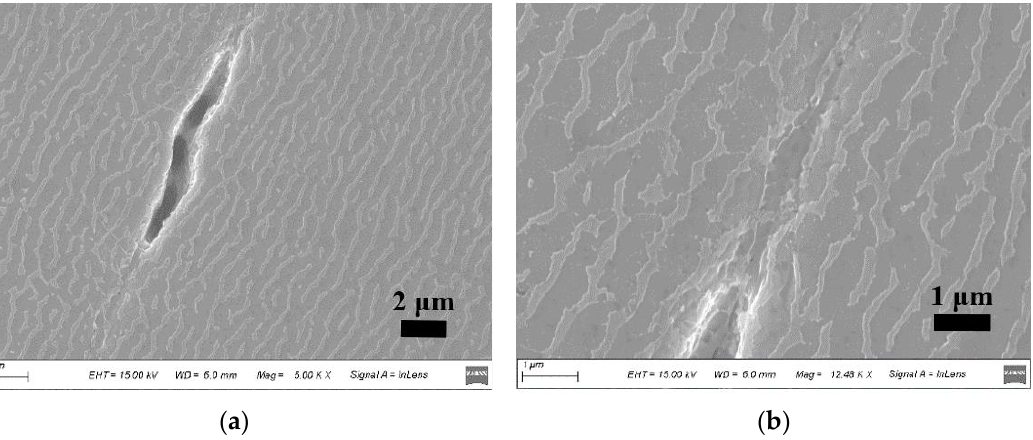
Figure 12. Creep crack shape at 980 °C/300 MPa. ( a ) Full view of the crack and ( b ) Crack